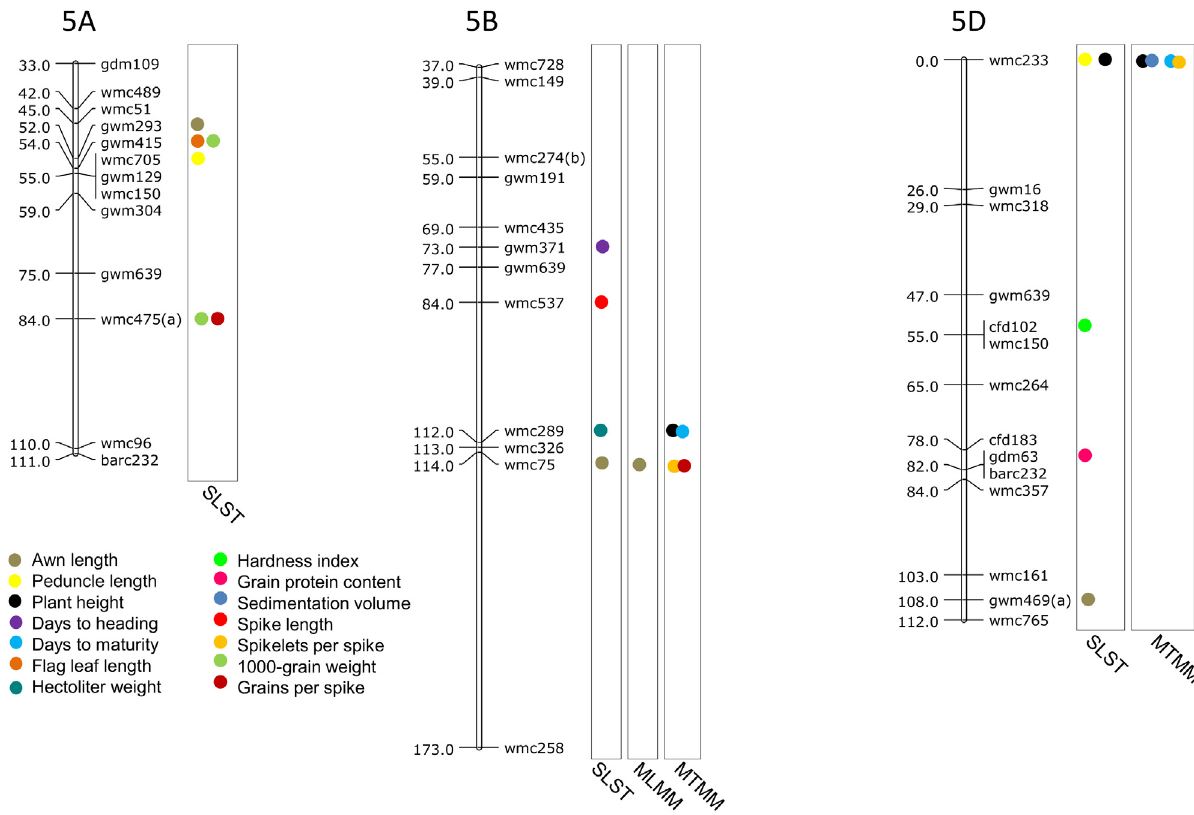
Fig 7. SSR genetic linkage maps of homoeologous group 5 chromosomes showing markers-trait associations (markers associated with different traits are shown by solid circles with different colours); markers are indicated to the right and map distances (cM) are indicated to the left of the vertical bar (based on the consensus linkage map of Somers et al. [76]).